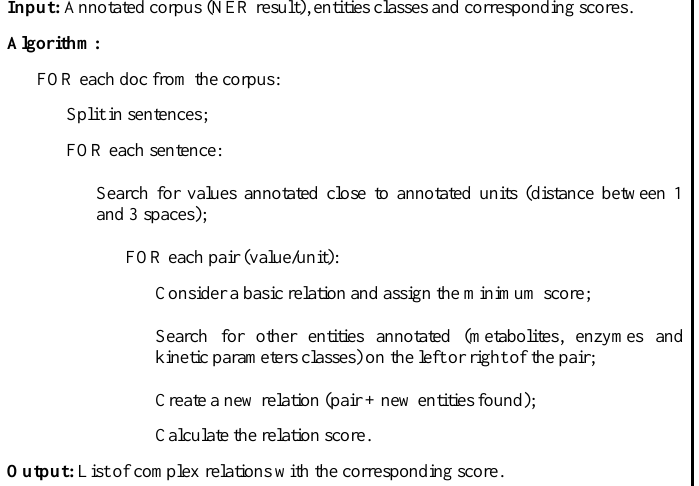
Figure 4: Example of a sentence with only one value-unit pair.